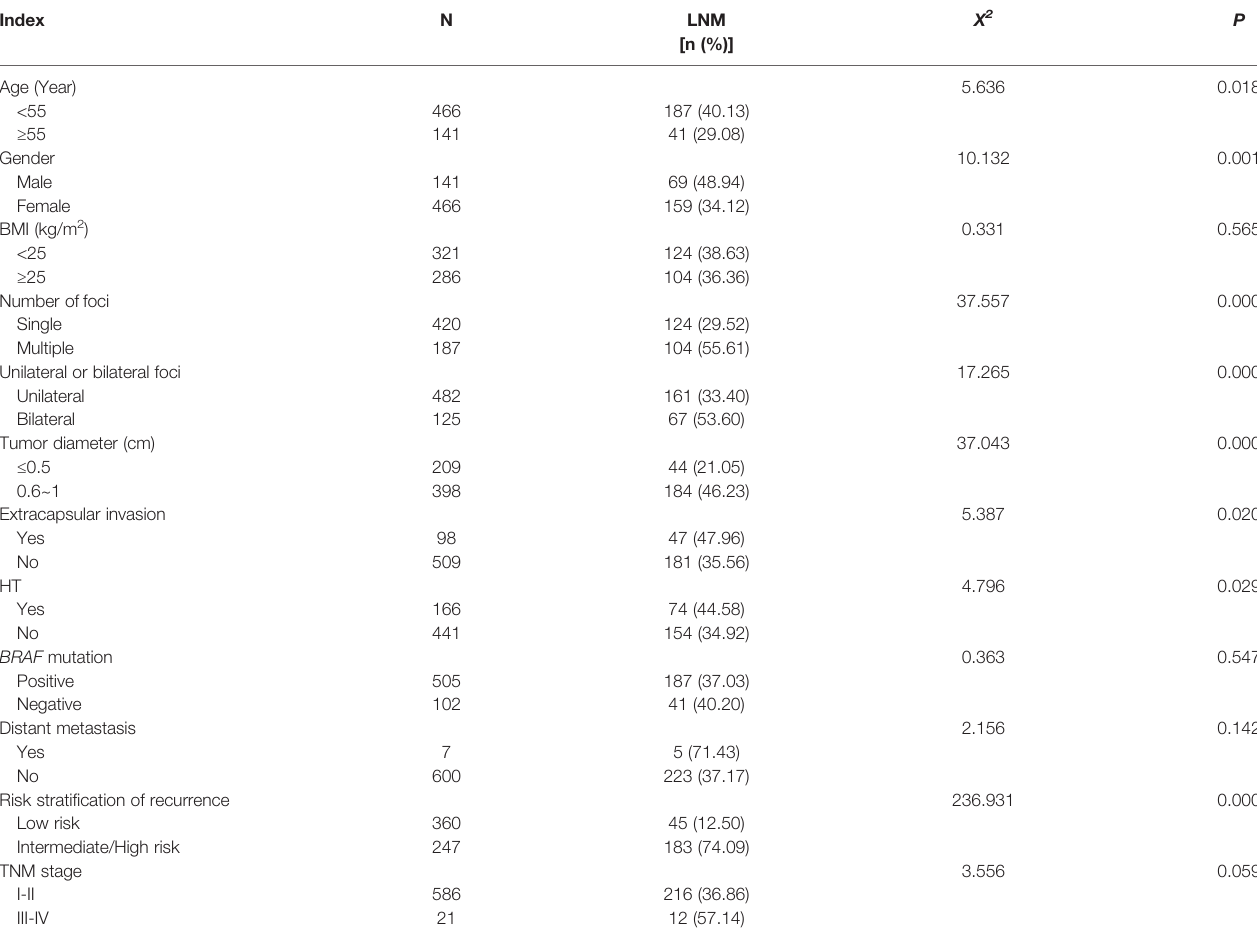
TABLE 2 | Analysis of the risk factors of LNM between various clinicopathological characteristics (n %).